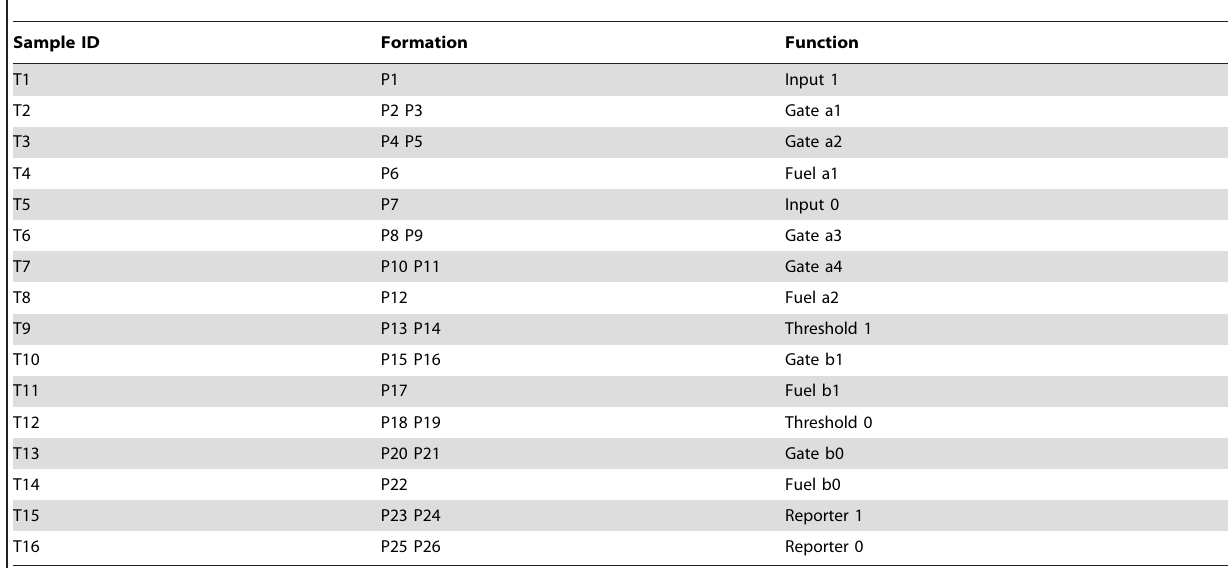
Table 4. Components samples.